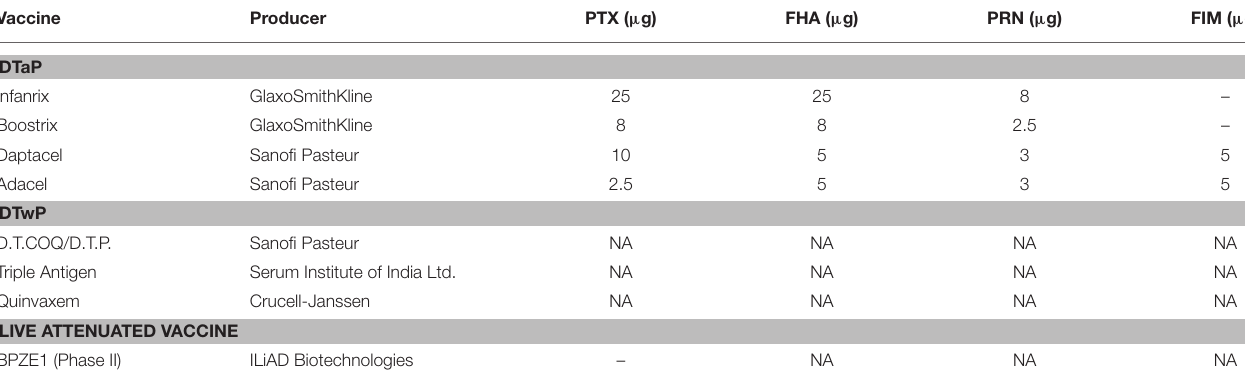
TABLE 1 | Vaccine formulations against pertussis.